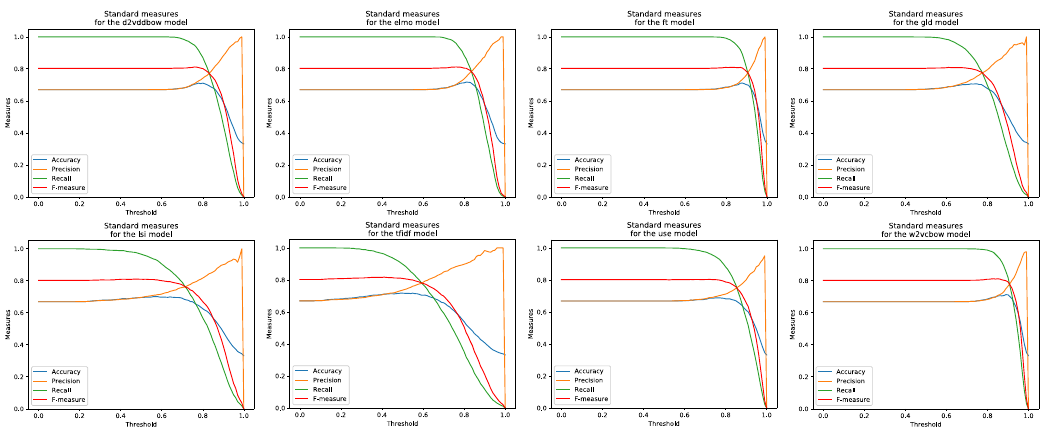
Figure 6. Standard evaluation measures for eight models processing MSRP corpus. Information 2020 , 11 , x FOR PEER REVIEW